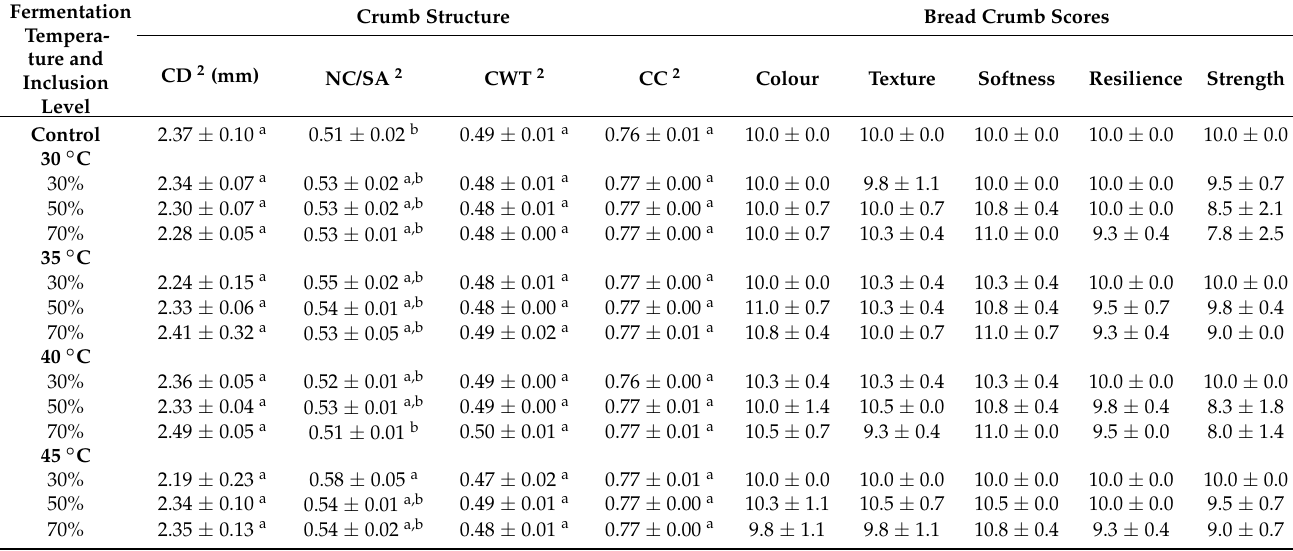
1 Different letters within the same column indicate significant differences for the results for each parameter at p < 0.05 (Tukey–Kramer test). Table 12. Crumb structure parameters and bread scores of the control and breads containing ferment prepared during varying fermentation temperatures 1